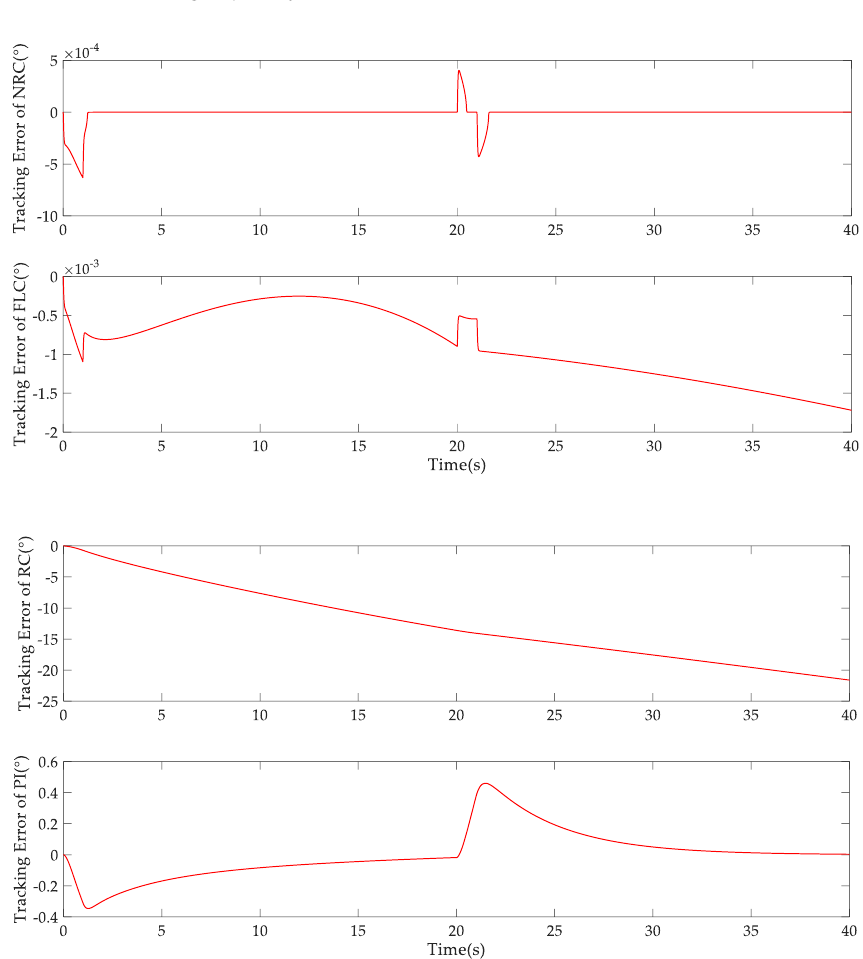
Figure 4. The tracking errors of four controllers.